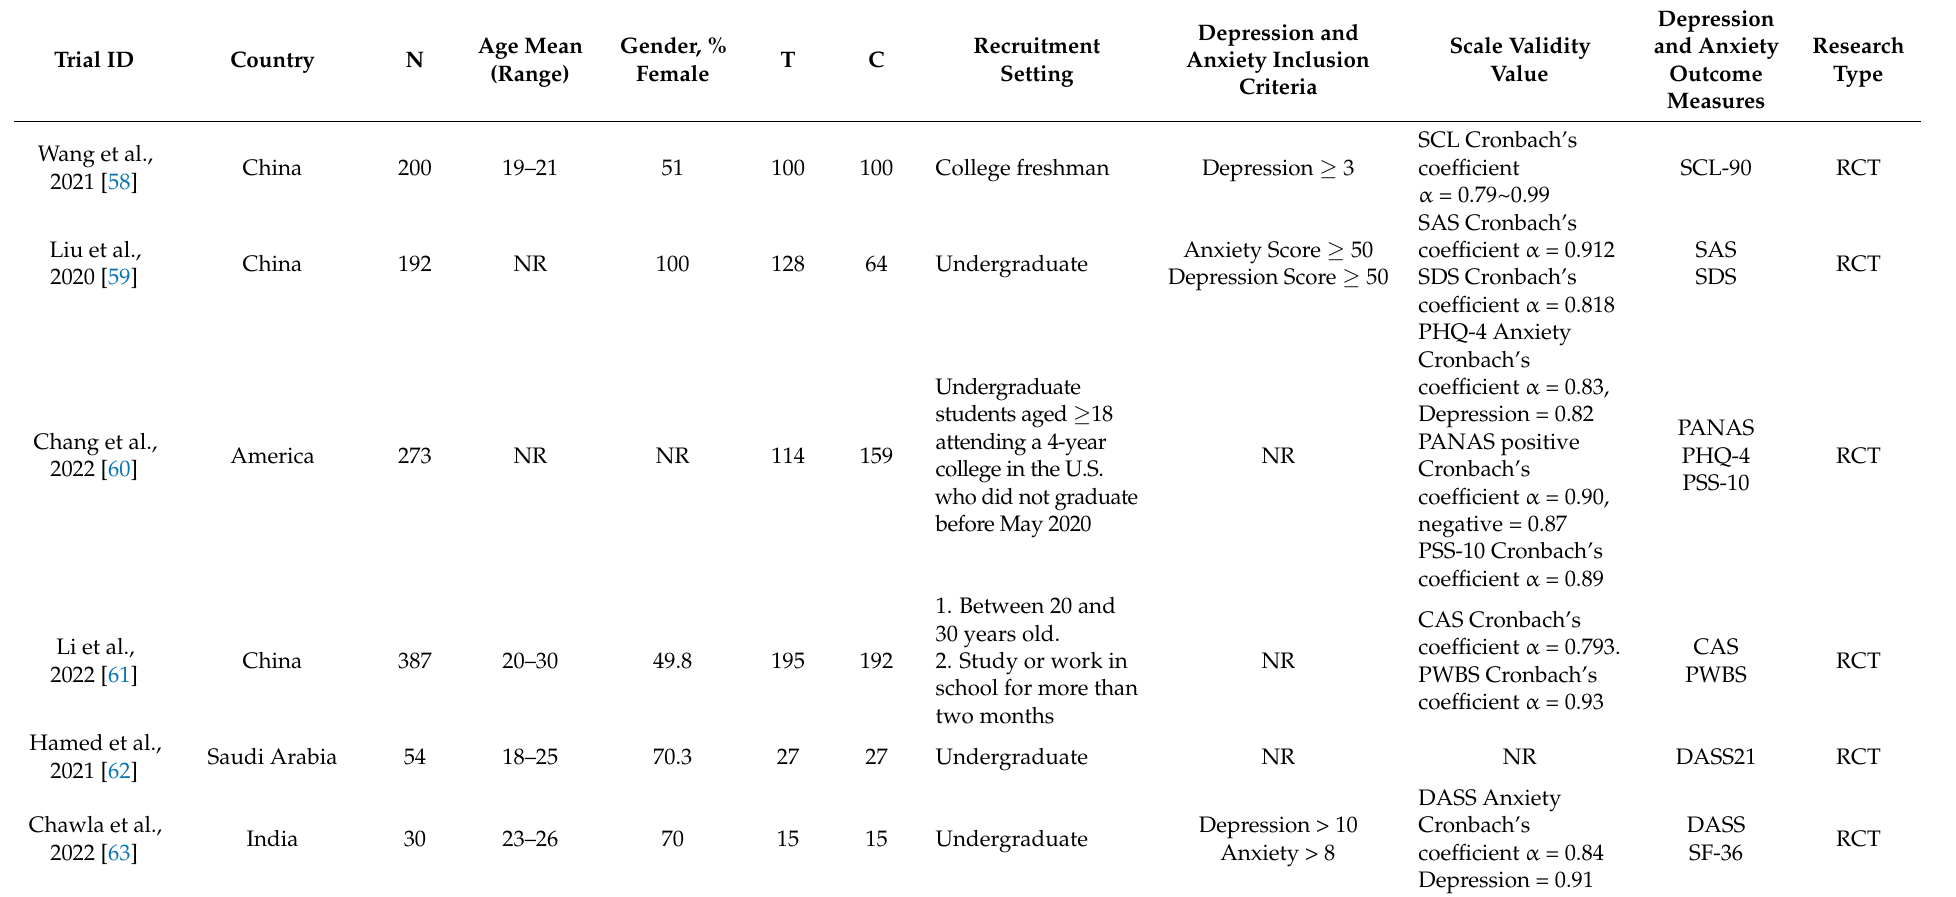
Table 2. Included trial